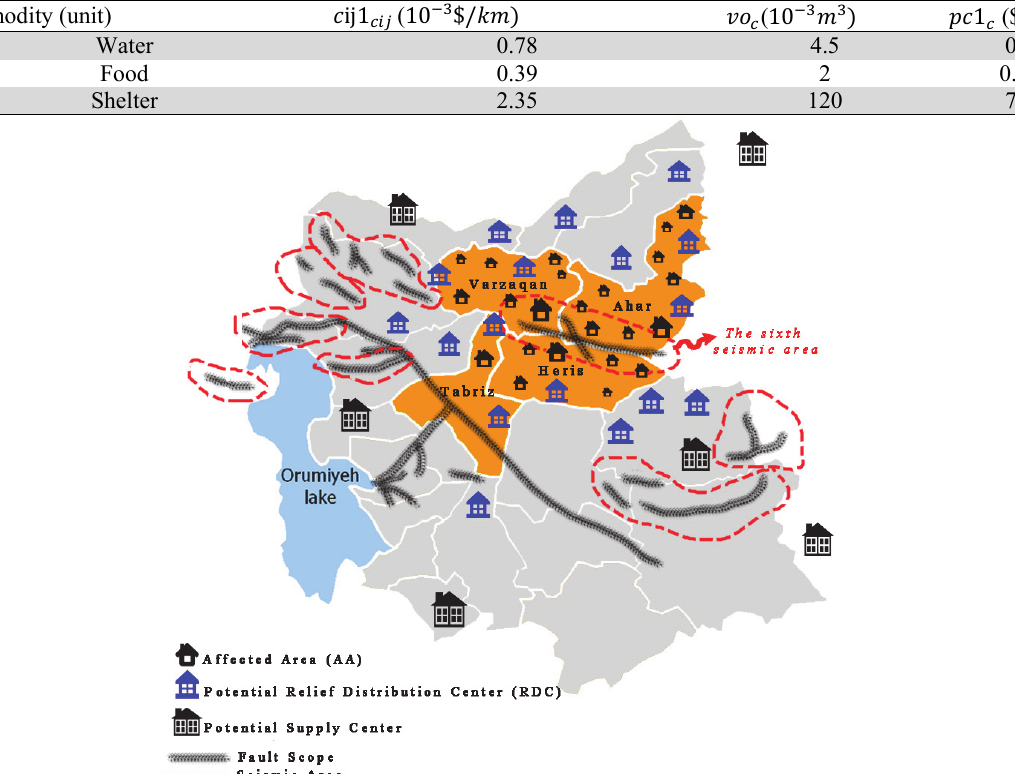
Fig. 5. Potential AAs, potential RDCs and suppliers in the sixth seismic zonation of East Azerbaijan